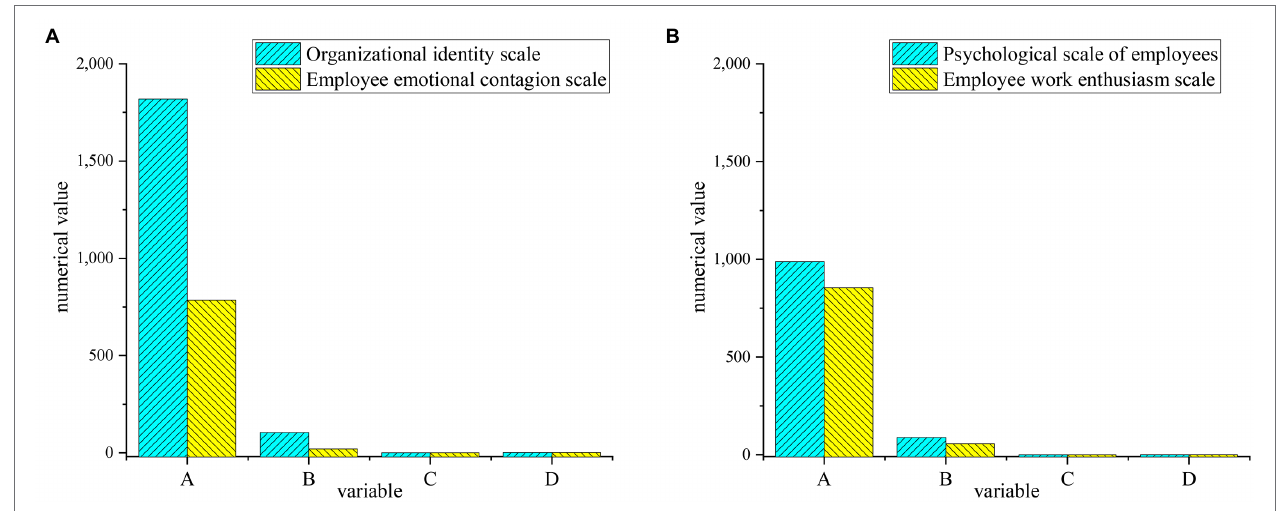
FIGURE 9 | Results statistics of validity analysis. (A) Validity analysis of organizational learning environment variables and resource environment variables; (B) Validity analysis of strategic environment variables, innovation variables, and enterprise performance variables. (A: approximate chi-square; B: degrees of freedom; C: significance; and D: statistical test of the four